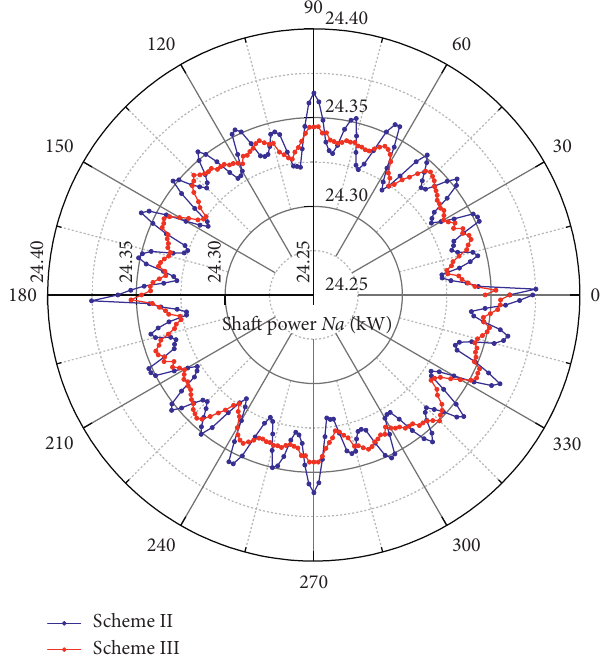
Figure 14: Power variation curve of blade shaft ( Q � Q